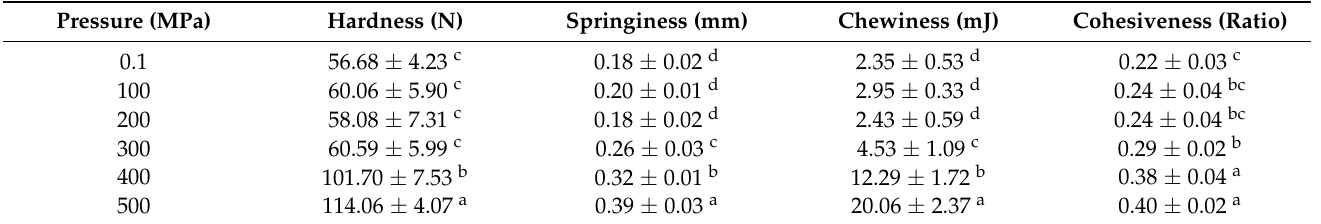
Table 2. Effects of HHP treatment on texture parameters of adductor muscle in